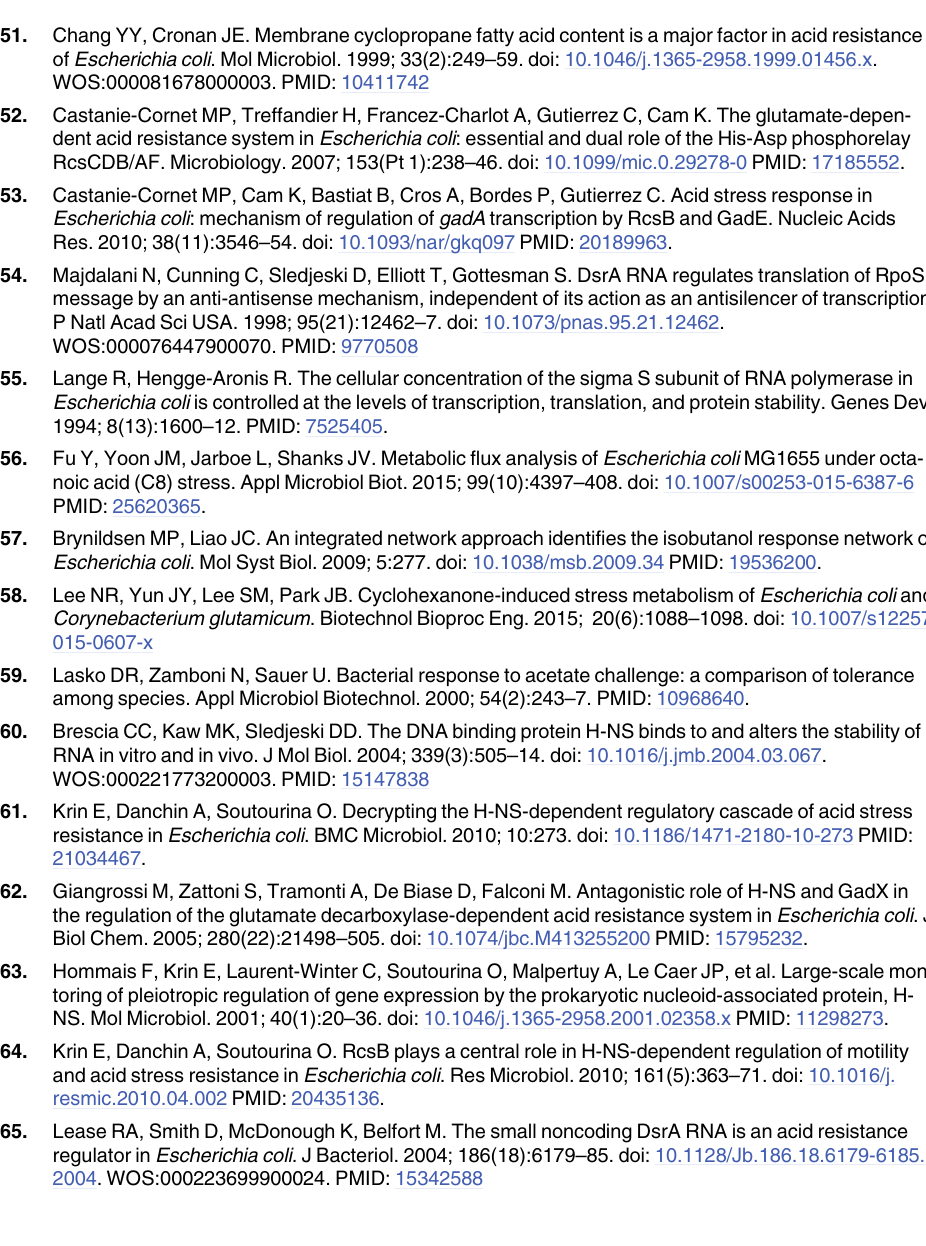
PLOS ONE | DOI:10.1371/journal.pone.0163265 September 28,